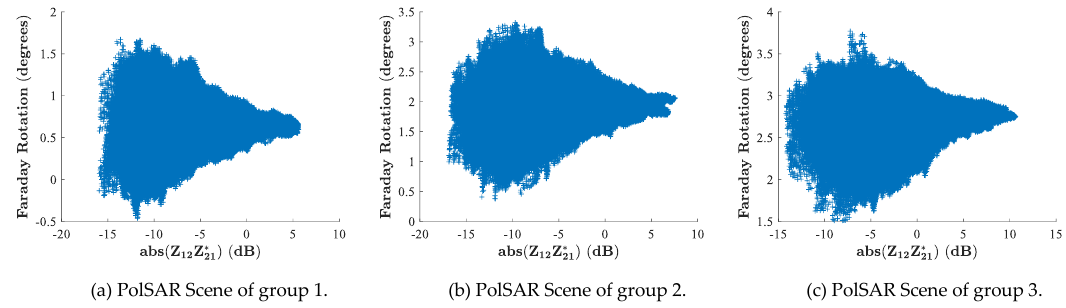
Figure 4 . Faraday rotation (FR) estimates as a function of signal amplitude. PolSAR: polarimetric spaceborne synthetic aperture radar.